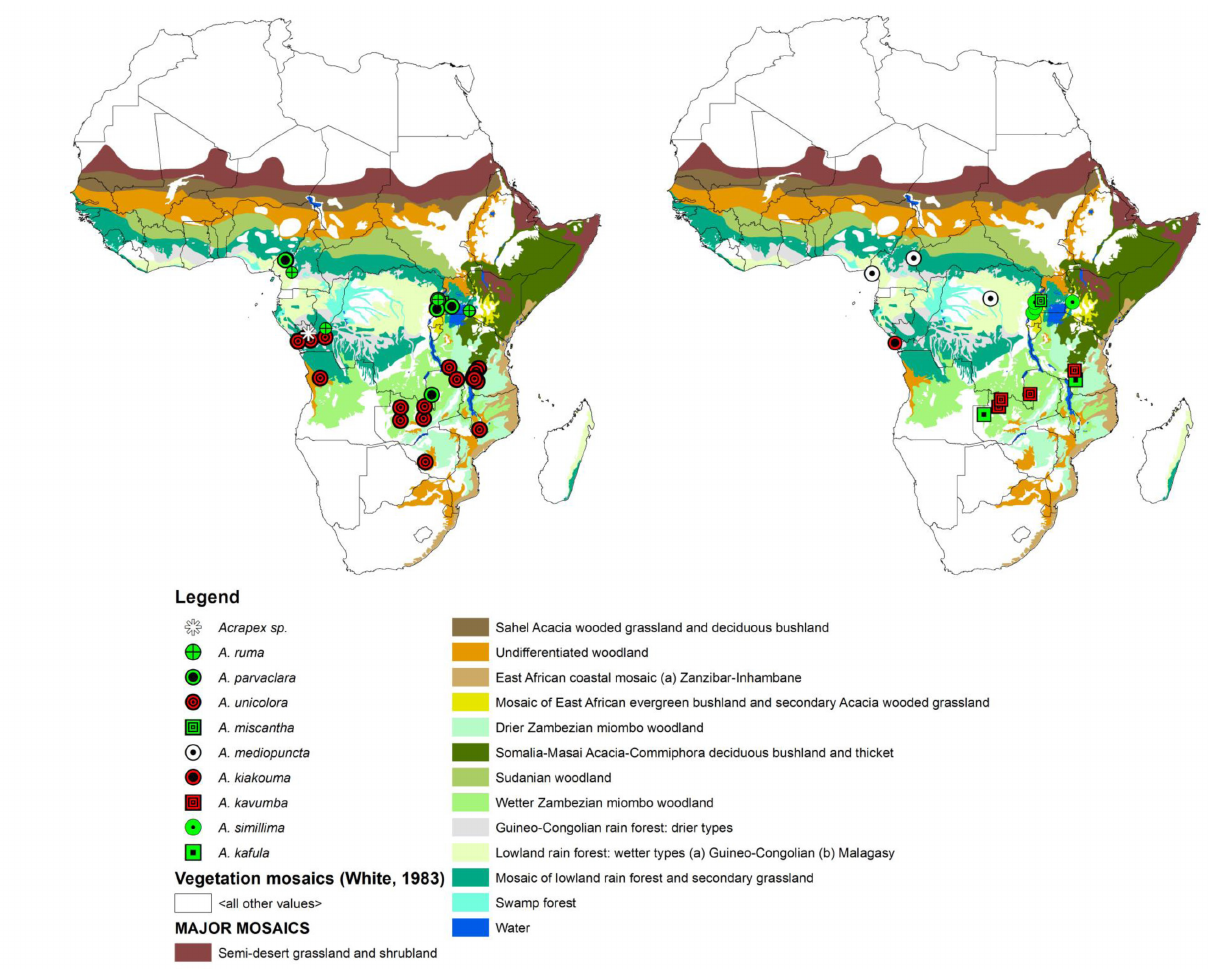
Fig. 4. Distribution map of sampled specimens of Acrapex Hampson,